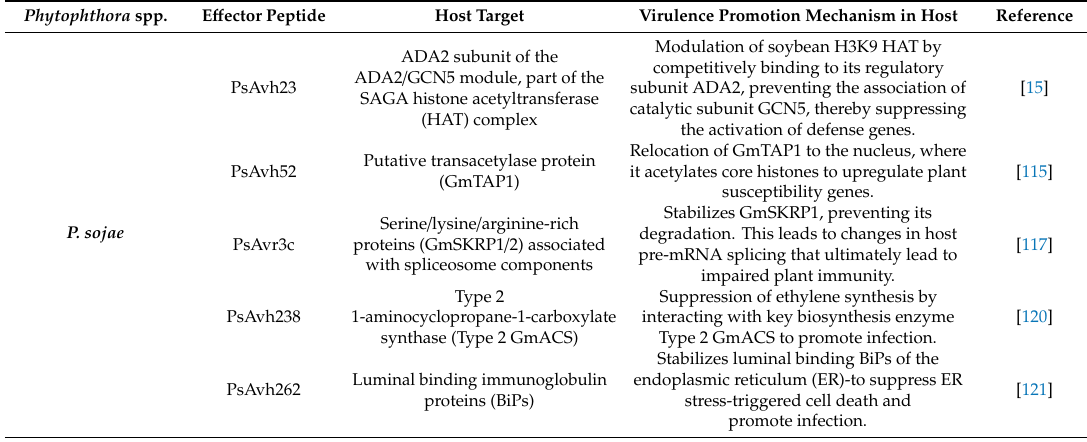
Table 2. Examples of Phytophthora spp. e ff ector peptides and the associated infection mechanisms. Phytophthora